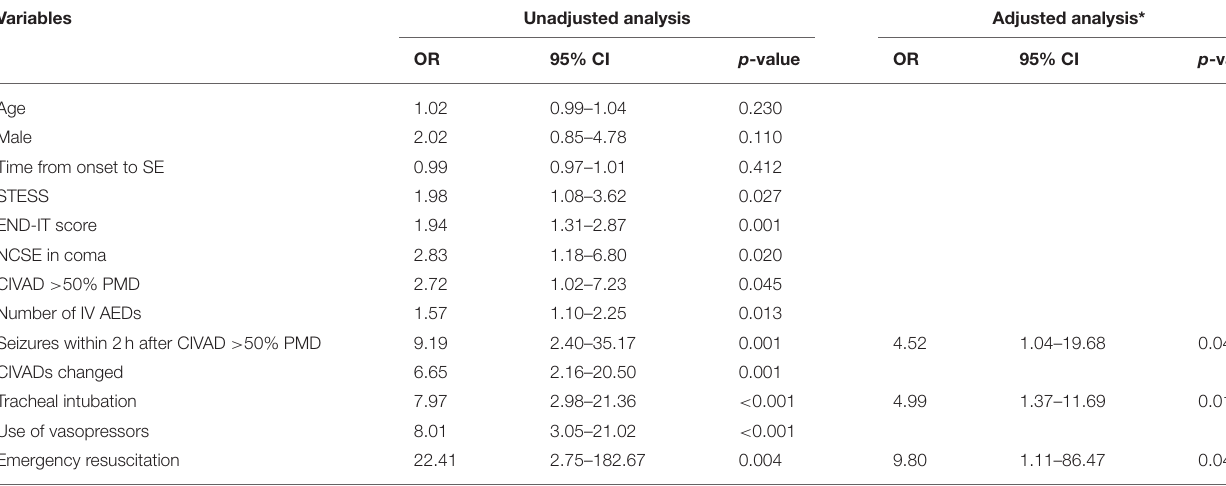
TABLE 5 | Logistic regression analysis for three-month unfavorable